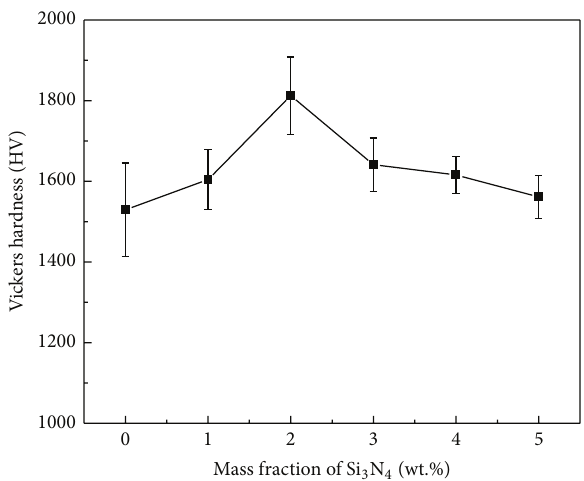
Figure 6: Bending strength of the as-prepared TiCN-based cermets as a function of mass fraction of Si 3 N 4